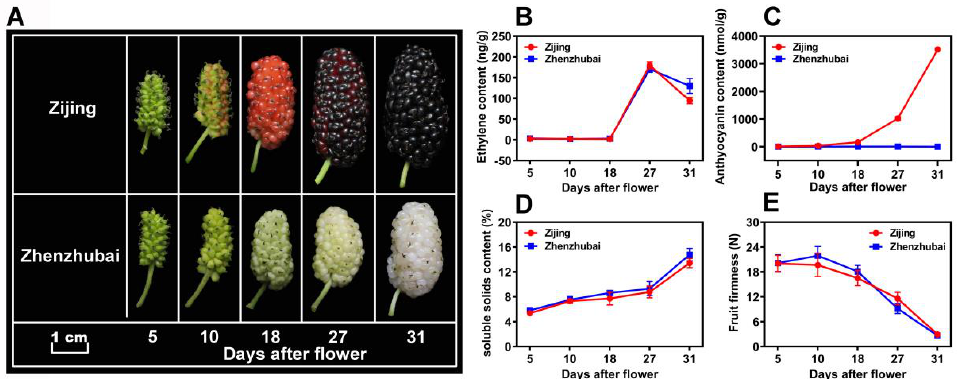
Figure 1. Fruit morphologies and physiological trends of Mulberry ‘Zi Jing’ (ZJ) and ‘Zhen Zhu Bai’ (ZZB) at different developmental stages. ( A ) Morphological profiles of the mulberry fruits from ZZB and ZJ. ( B – E ) Ethylene content, anthocyanin content, soluble solids content and fruit firmness, respectively, for ZJ and ZZB at different DAF. The white horizontal bar in panel A represents 1 cm in length. Each data point of the curves in panels ( B – E ) represents the mean of three independent replicates (±SE).